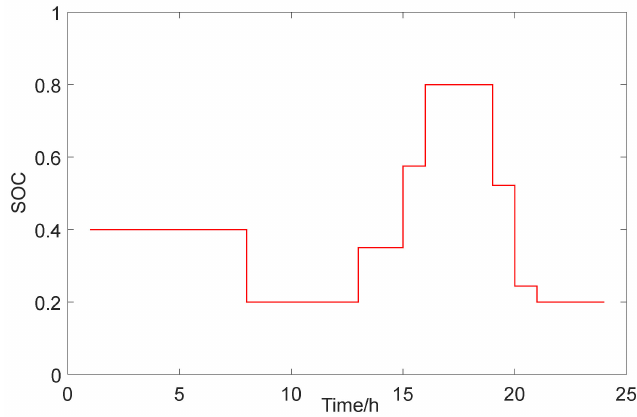
Figure 12. State of charge (SOC) of storage